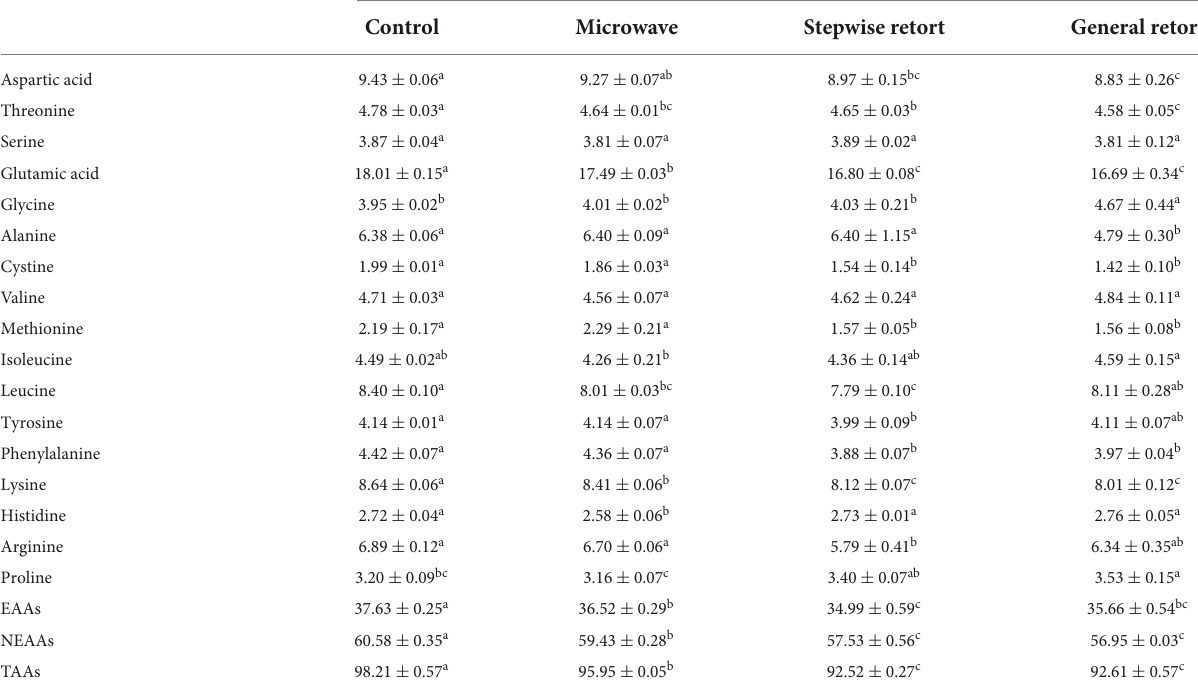
TABLE 2 Hydrolyzed amino acids of duck meat treated with no thermal sterilization and three sterilization strategies. Hydrolyzed amino acids Relative content (%) Control Stepwise